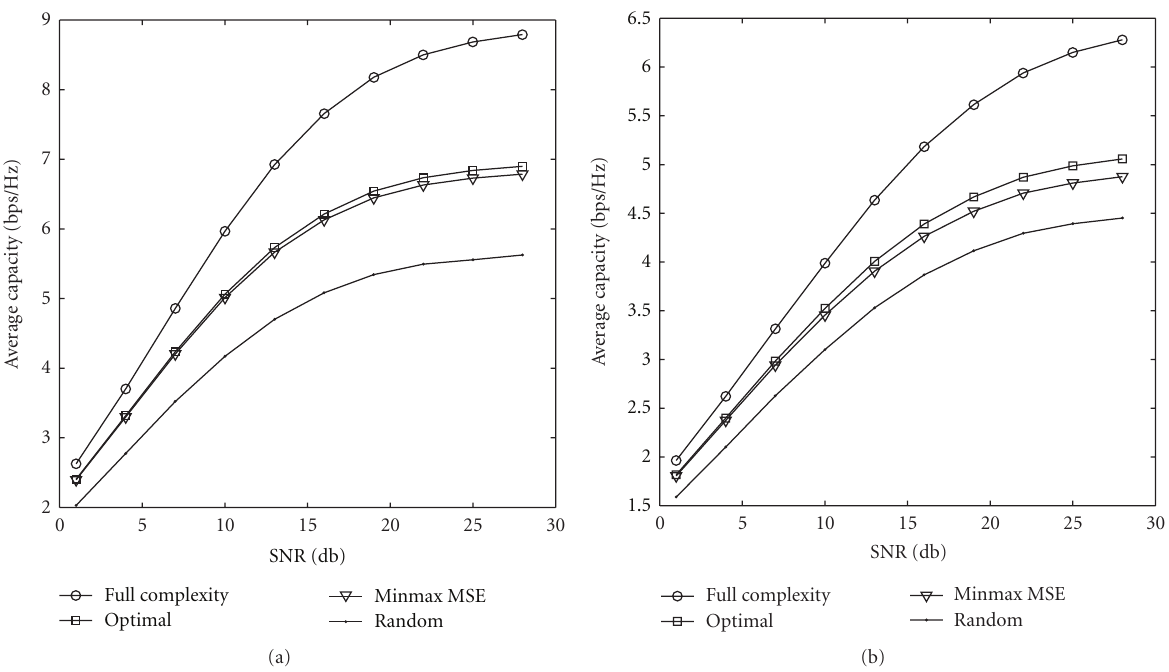
Figure 3: System-capacity performance comparisons of various destination antenna selection algorithms in terms of SNR for an AF-MIMO multiple-relay system with [ N S , N R , N D , N , K , L ] = [10,2,10,10,4,4] and a fixed relay antenna-pair selection process in the (a) low and (b) high spatial-correlation